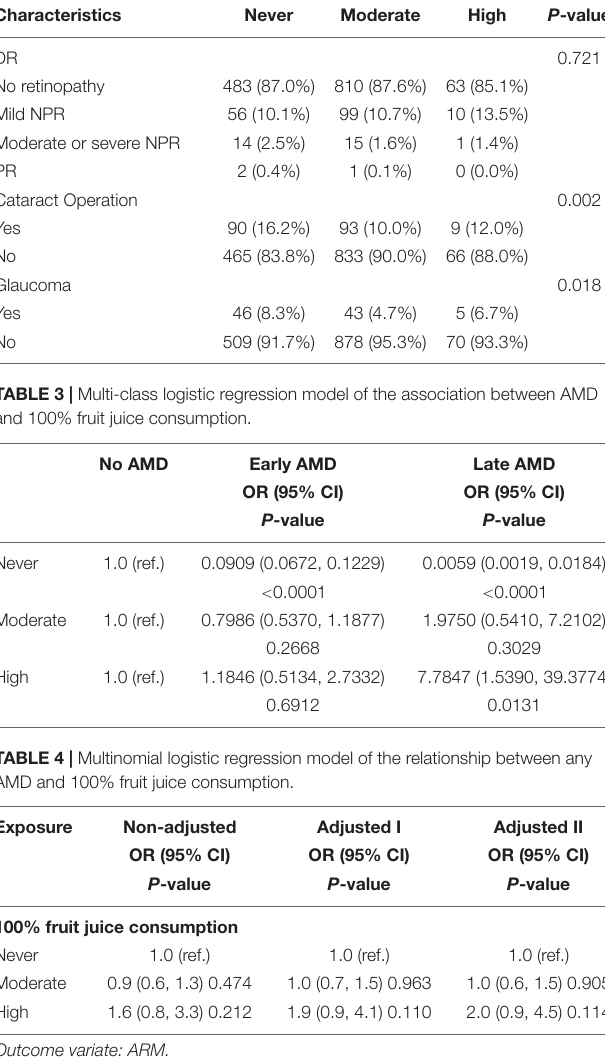
TABLE 2 | Socio-demographic and clinical characteristics by 100% fruit juice consumption. 100% fruit juice consumption